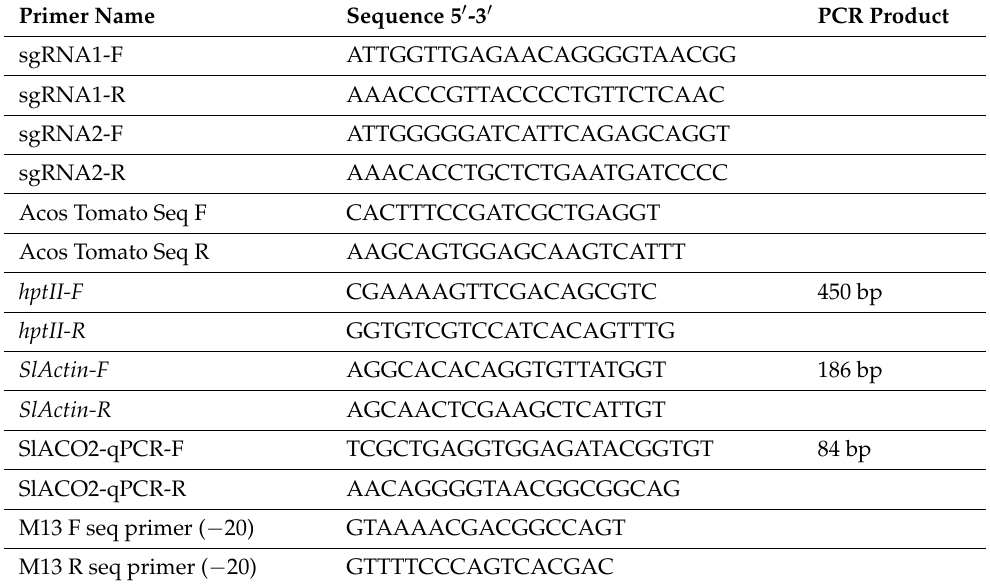
Table 2. List of primers used in this